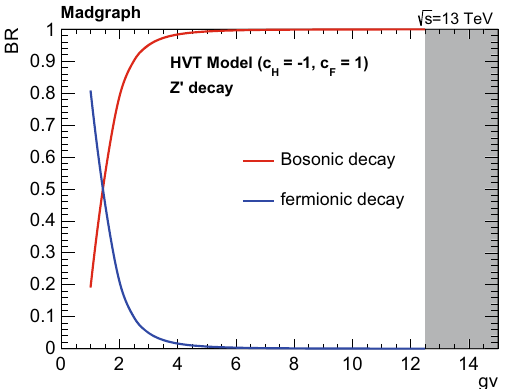
Fig. 5 Heavy resonance branching ratio to bosonic and fermionic decays as a function of the g V